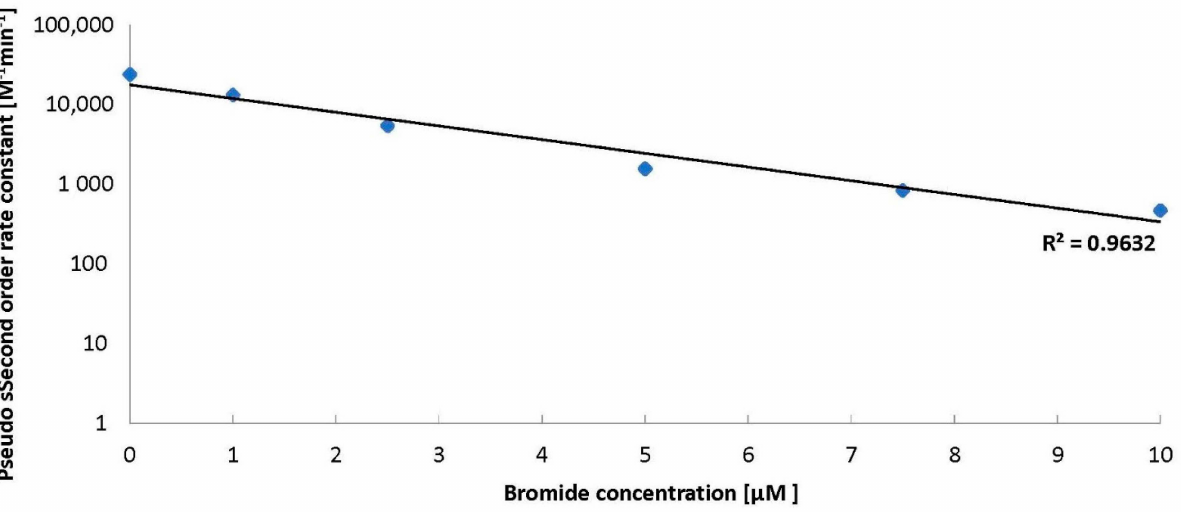
Figure 4. The degradation kinetics of BA (24 µ M) in the presence of bromides (0–15 µ M), pH =